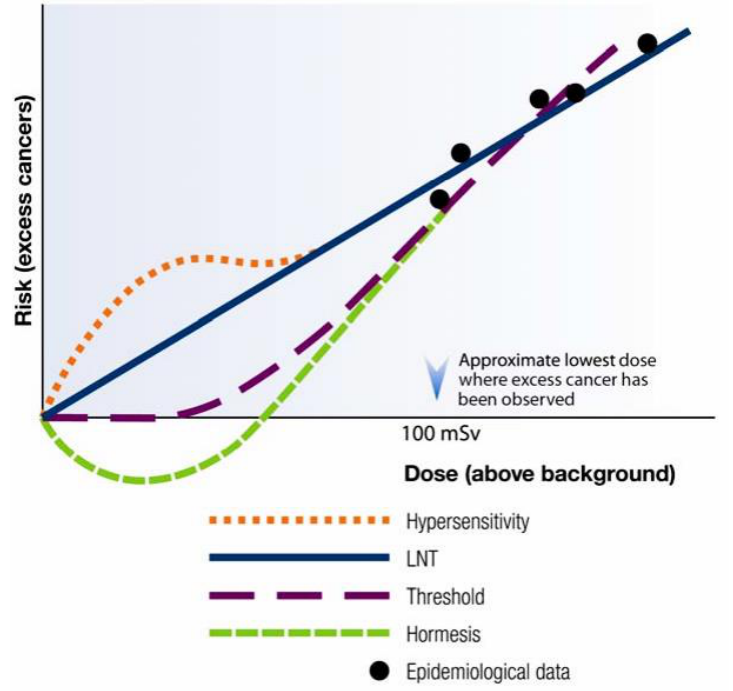
Figure 1. Different radiation risk models illustrating the estimated health risk at low levels of ionizing radiation (Reprinted with permission from Ref. [45]. 2022, Canadian Nuclear Safety Commission).